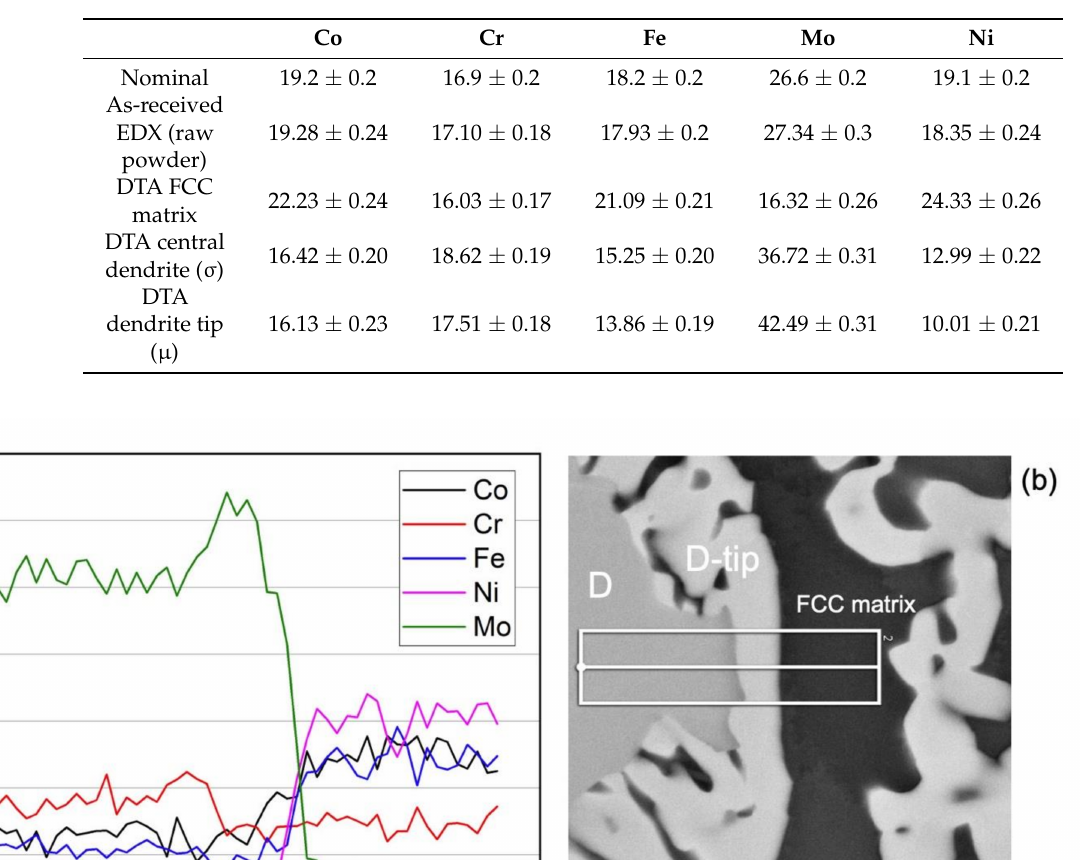
Table 4. Nominal and measured chemical compositions of CoCrFeMo 0.85 Ni high-entropy alloy: Raw powder and DTA samples (wt%).